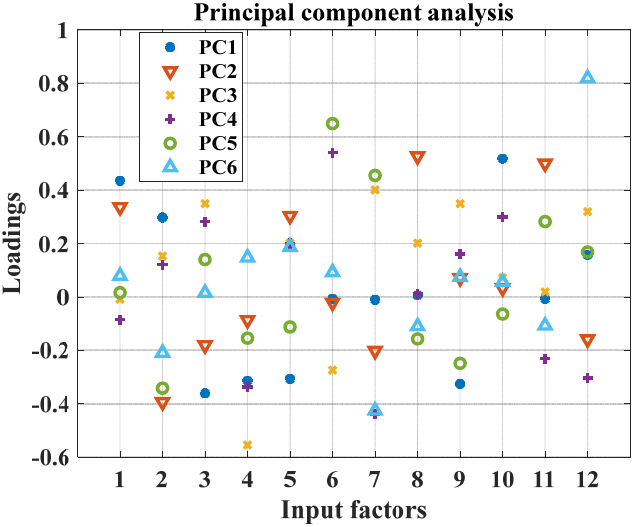
Figure 7. Principal component analysis result for the input variables.